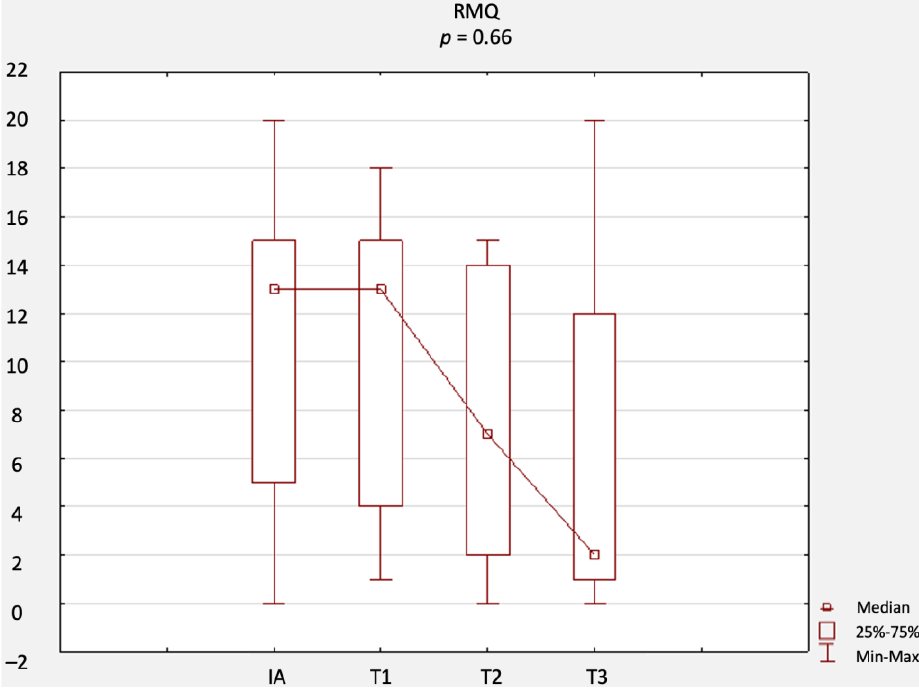
Figure 4. Comparison of RMQ results at IA, T1, T2, and T3. Abbreviations: RMQ, Roland–Morris questionnaire; IA, initial assessment; T1, first-month assessment; T2, second-month assessment; T3, third-month assessment.